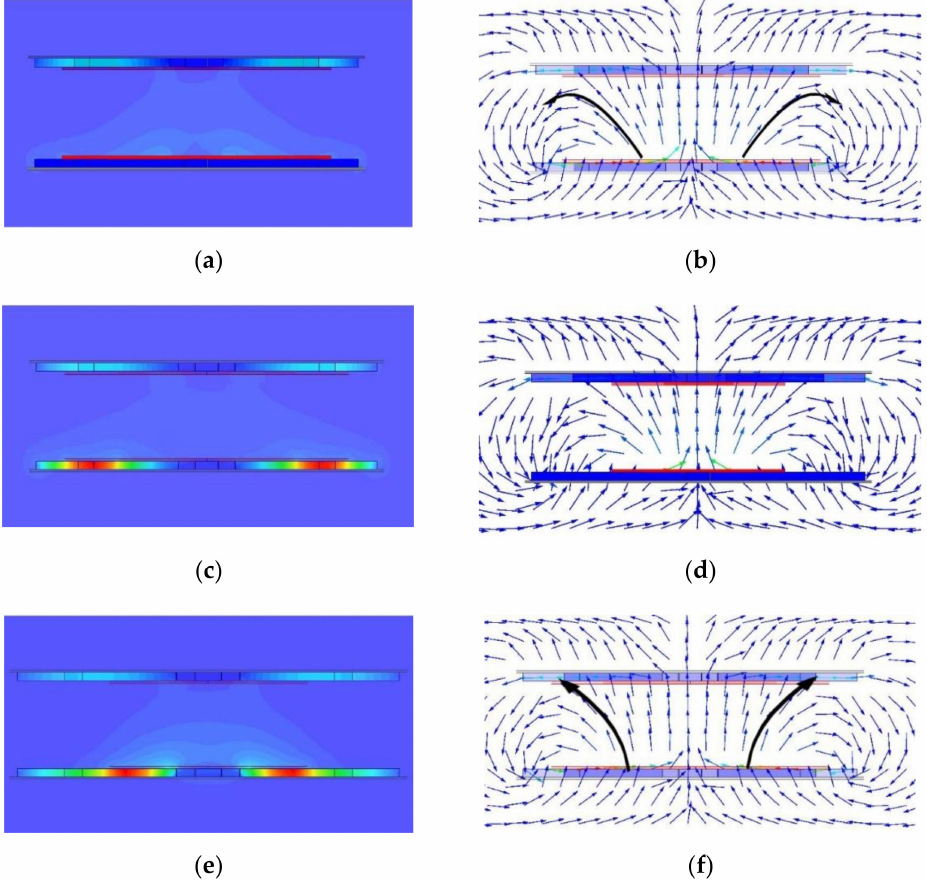
Figure 4. Spatially magnetic field distribution of the circular transformer with different inner and outer diameters: ( a ) nephogram of magnetic field intensity in coil with narrow inner diameter; ( b ) vector diagram of magnetic field intensity in coil with narrow inner diameter; ( c ) nephogram of magnetic field intensity in coil with wide inner diameter; ( d ) vector diagram of magnetic field intensity in coil with wide inner diameter; ( e ) nephogram of magnetic field intensity in coil with narrow outer diameter; ( f ) vector diagram of magnetic field intensity in coil with narrow outer